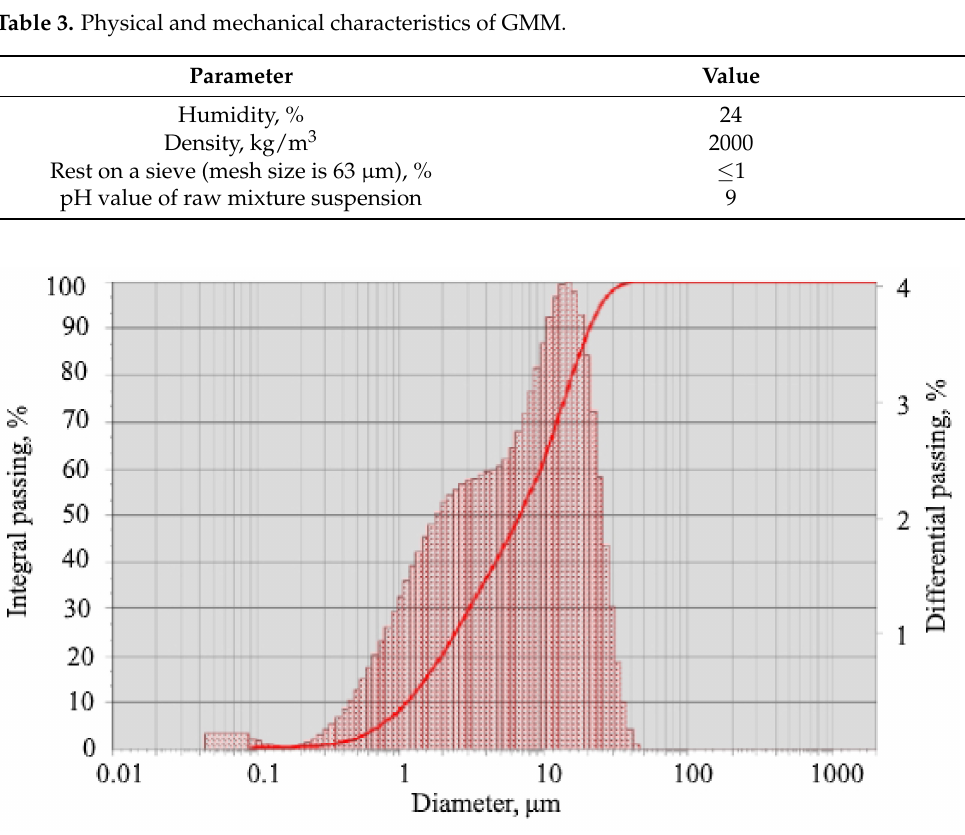
Figure 1. Particle size of the mineral